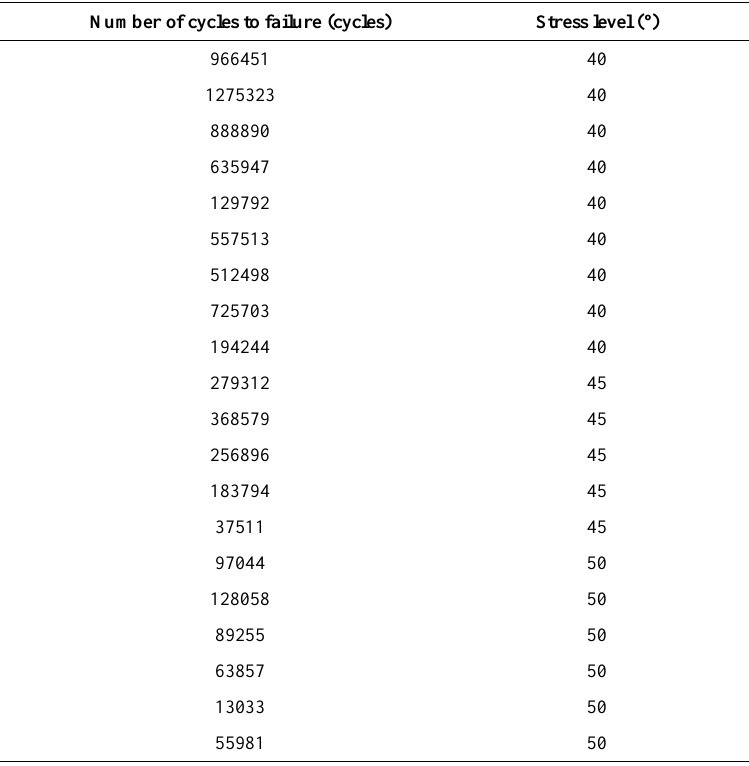
Table 8. Number of cycles to failure at different twist angles.